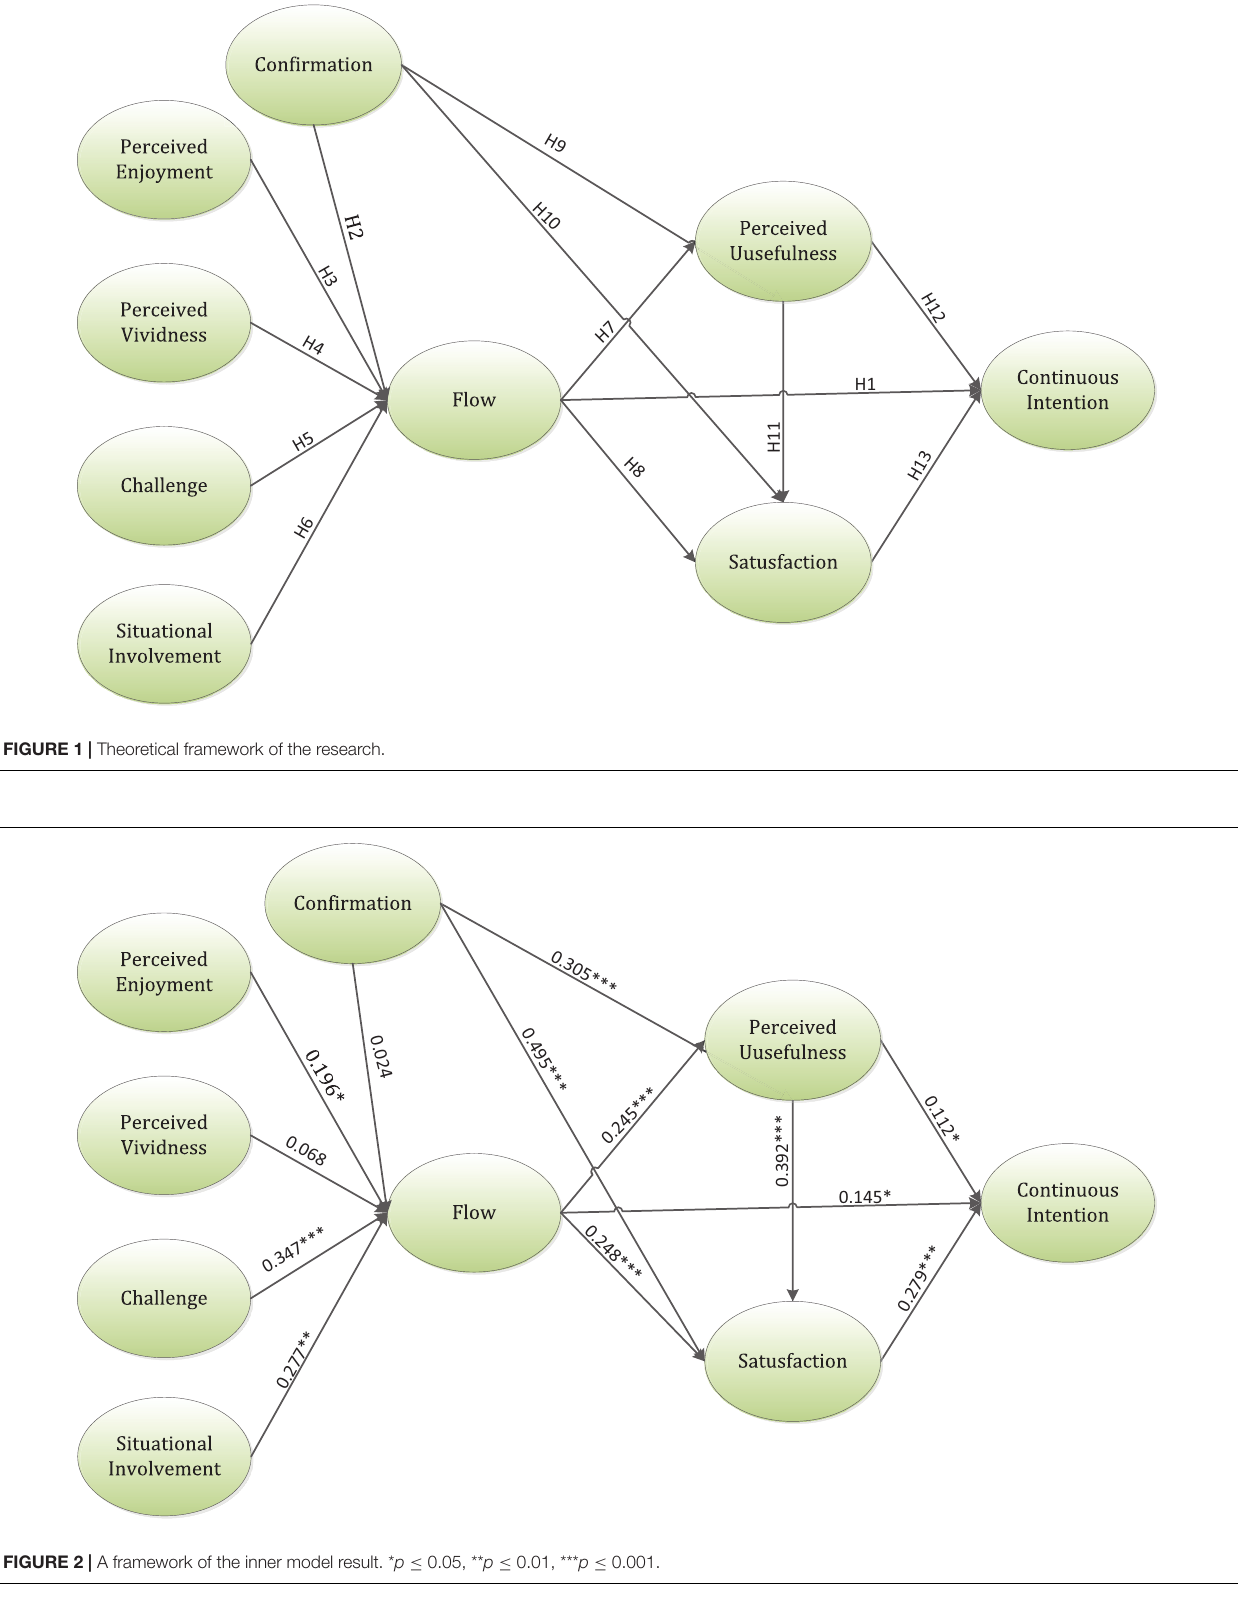
Frontiers in Psychology |